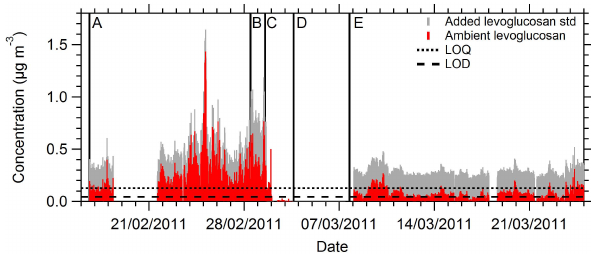
Fig. 3. Ambient levoglucosan concentrations during the campaign and the changes in the analytical conditions. The concentrations of ISTD and standard addition, respectively (ngmL − 1 ) : (A) 50 and 50, (B) 50 and 100, (C) 50 and 0, (D) 100 and 0, (E) 100 and